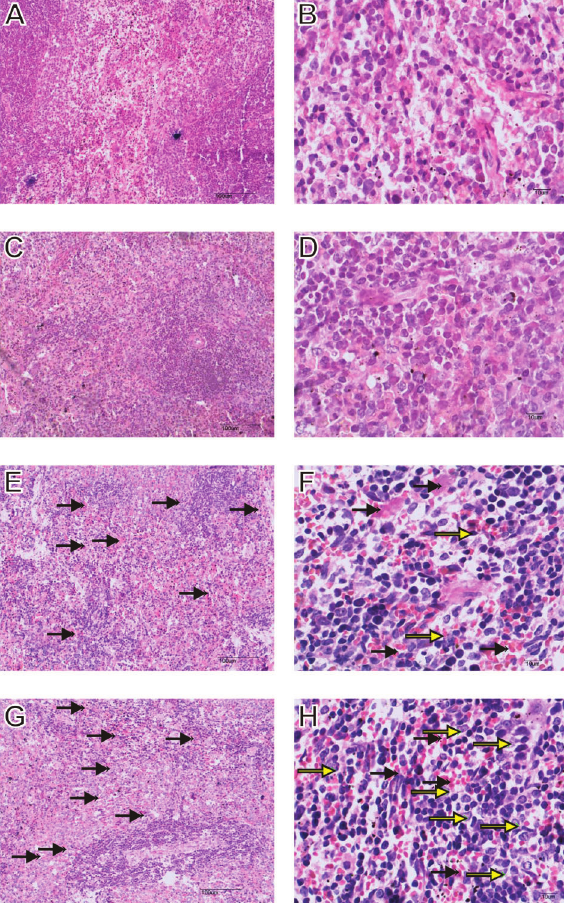
Figure 1. Effect of mesenteric lymph reperfusion (MLR) on splenic histomorphology in rats with superior mesenteric artery occlusion (SMAO) shock (H&E staining). A and B , Sham group. C and D , MLR group. E and F , SMAO group. G and H , MLR++SMAO group. Magnification bars: A , C , E , G : 100 m m; B , D , F , H : 10 m m. The normal structures in the splenic tissues of the sham and MLR groups are shown in panels A , B , C , and D . The congestion in the splenic sinuses (black arrows) and some swollen splenocytes (yellow arrows) were found in the SMAO group, as shown in panels E and F . The splenic tissue in the SMAO++MLR group revealed extensive congestion (black arrows) of the splenic sinuses and swollen splenocytes (yellow arrows), as shown in panels G and H